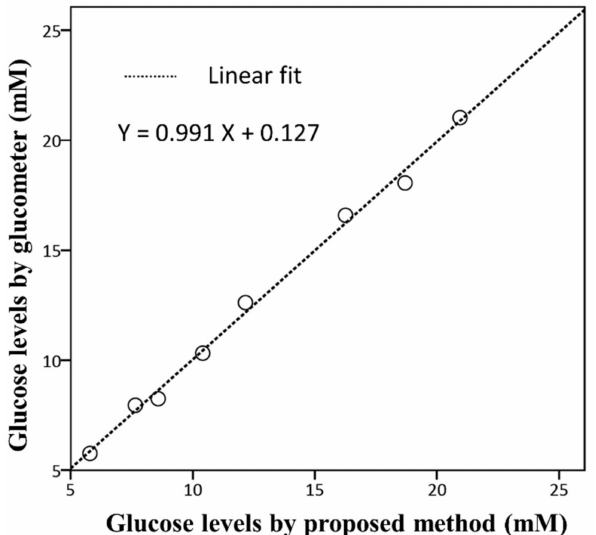
Figure 4. The fitted linear regression line of glucose levels detected by the proposed method versus the reference glucometer (8 blood samples from group 1 and group